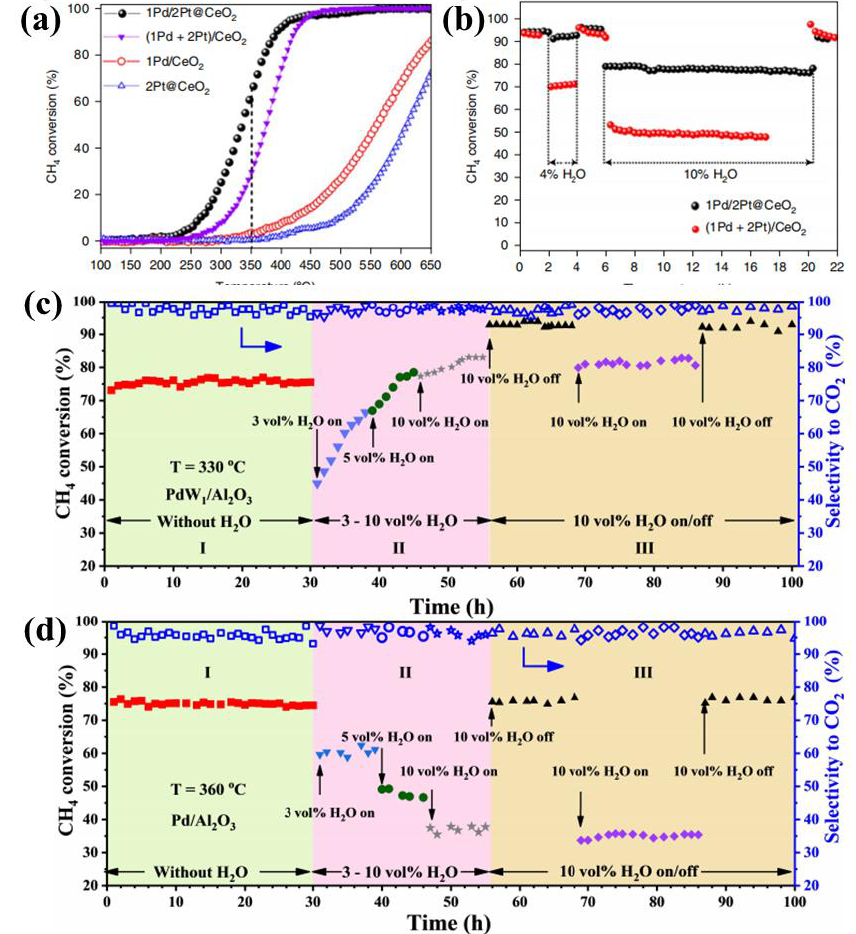
Figure 3. ( a ) Light-off curves of CH 4 combustion under dry conditions. ( b ) Time-on- stream measurements for CH 4 combustion at 500 °C under different steam